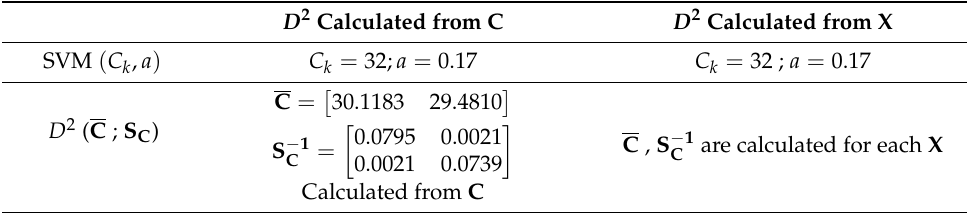
Table 3. Experimental parameters for SVM and D 2 . D 2 Calculated from C